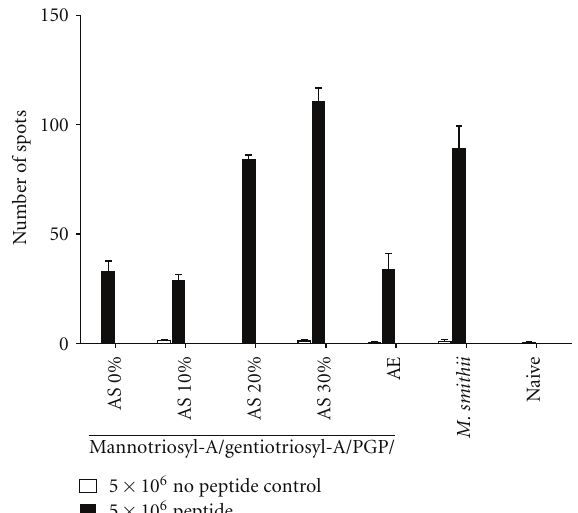
Figure 7: Cytotoxic T lymphocyte (CTL) lysis assay was used to assess the same populations of splenic cells as in Figure 6. Loadings of the OVA antigen are shown also in this figure. EL-4 control targets not expressing SIINFEKL gave < 10% lysis in all cases (not